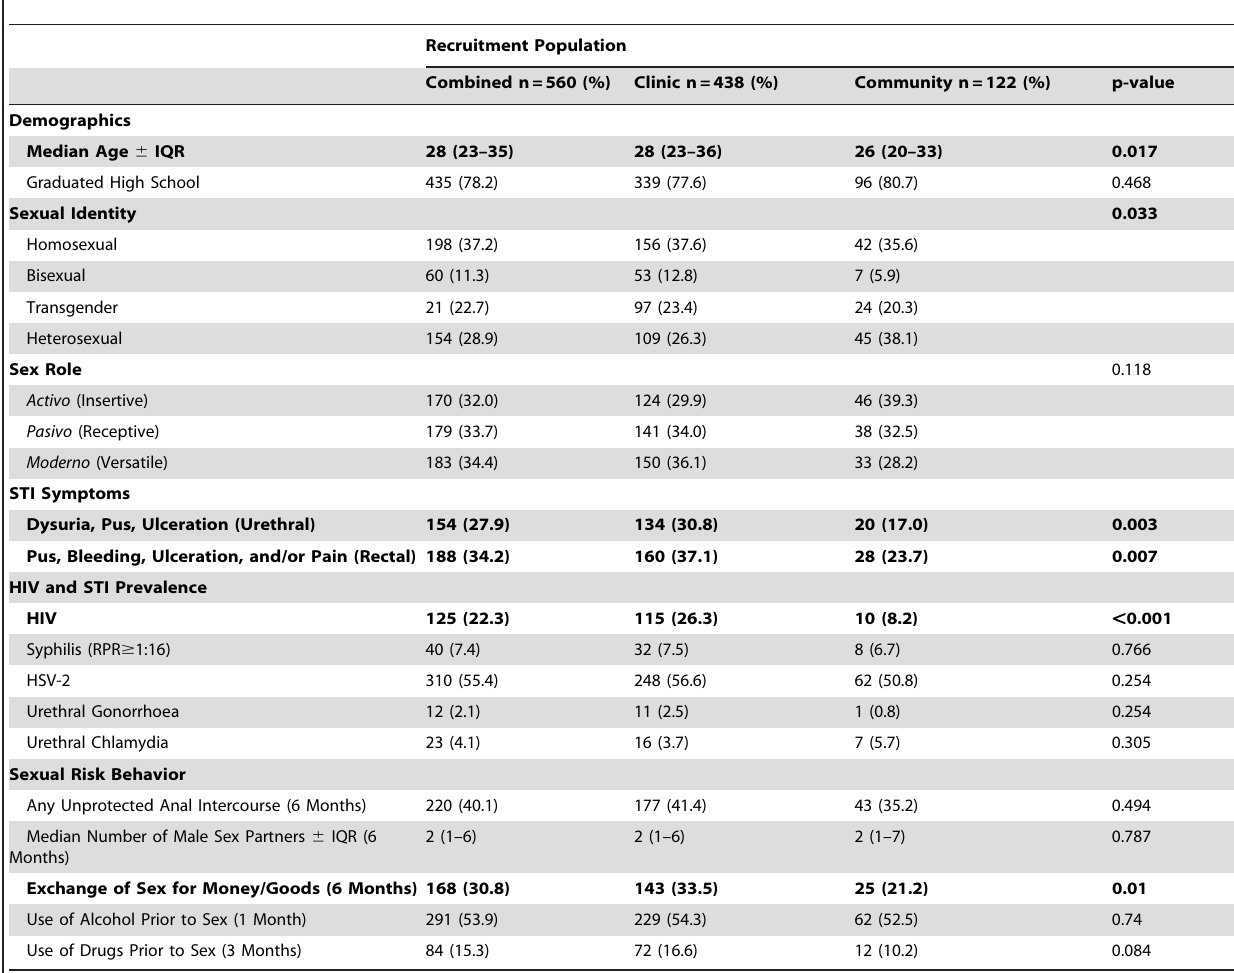
Table 1. Demographics, Prevalence of HIV, STIs, and Risk Behaviors in a Cross-Sectional Community-and Clinic-based Sample of Men Who Have Sex with Men in Lima, Peru;